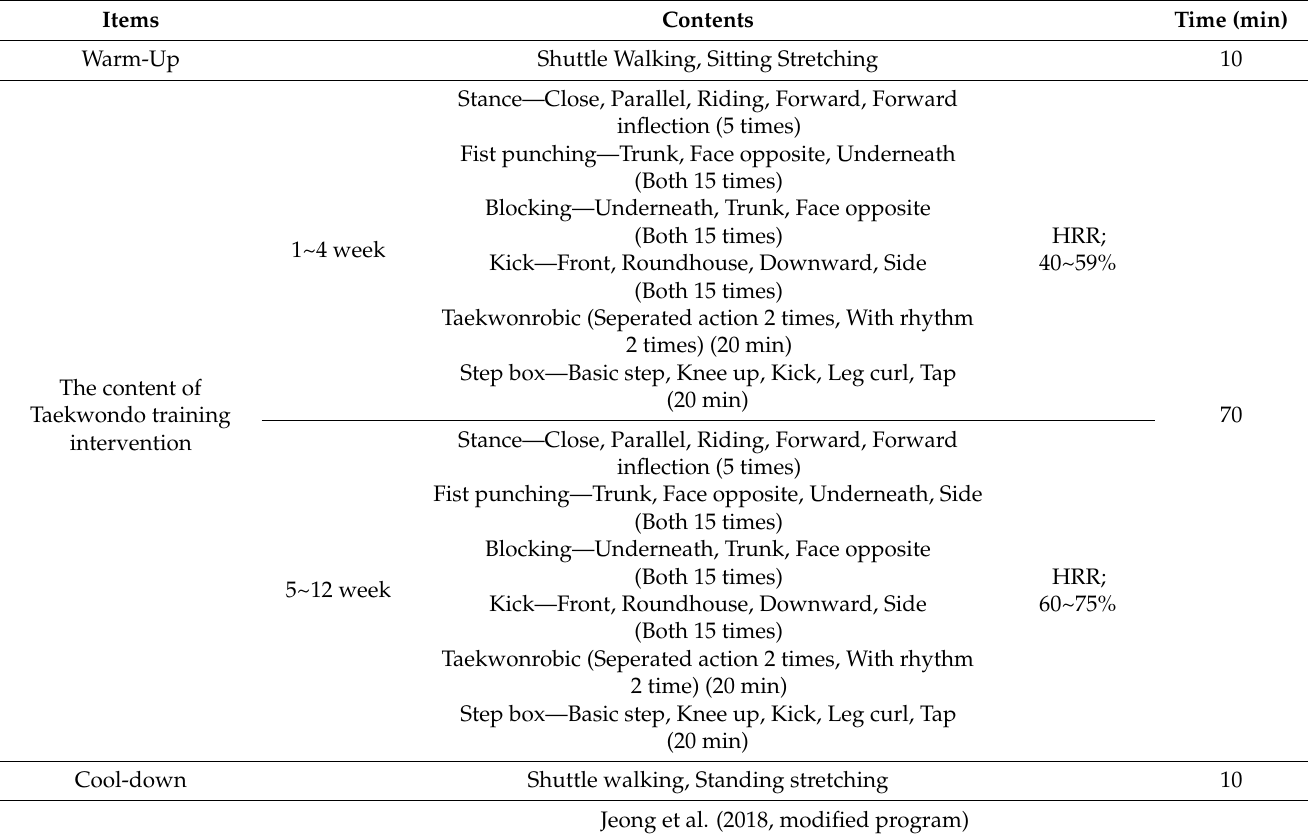
Table 2. Taekwondo training